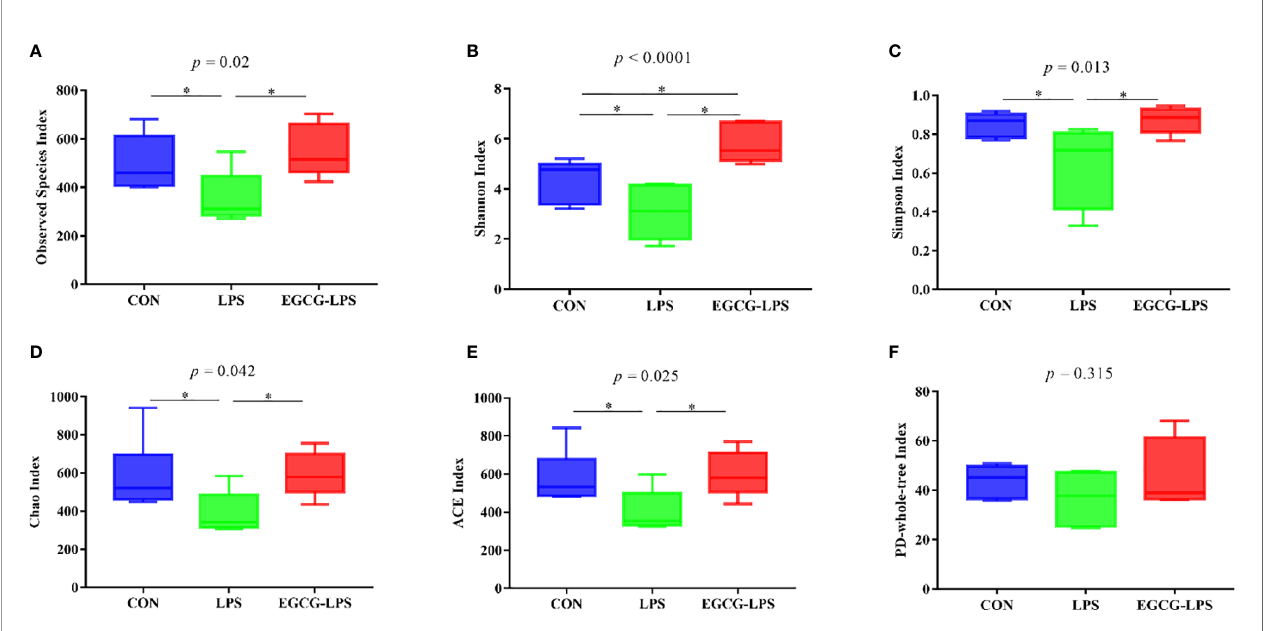
FIGURE 4 | The protective effect of the intragastric administration of EGCG on mouse gut microbial diversity. (A) Observed Species; (B) Shannon index; (C) Simpson index; (D) Chao index; (E) ACE index; (F) PD-whole-tree index. Data are mean ± SD (n = 6) and analyzed by one-way ANOVA. “ * ” means that the horizontal line connects the p -value of the data between the two groups <0.05, and the “ P ” value in the fi gure represents the accurate value of p between the three groups of data, and some of the p values between the three groups are too small to be expressed as p